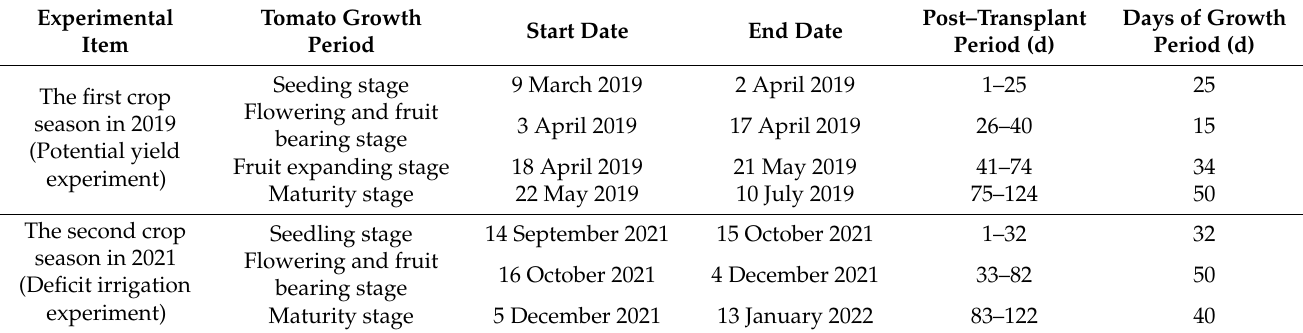
Table 1. Division of tomato growth